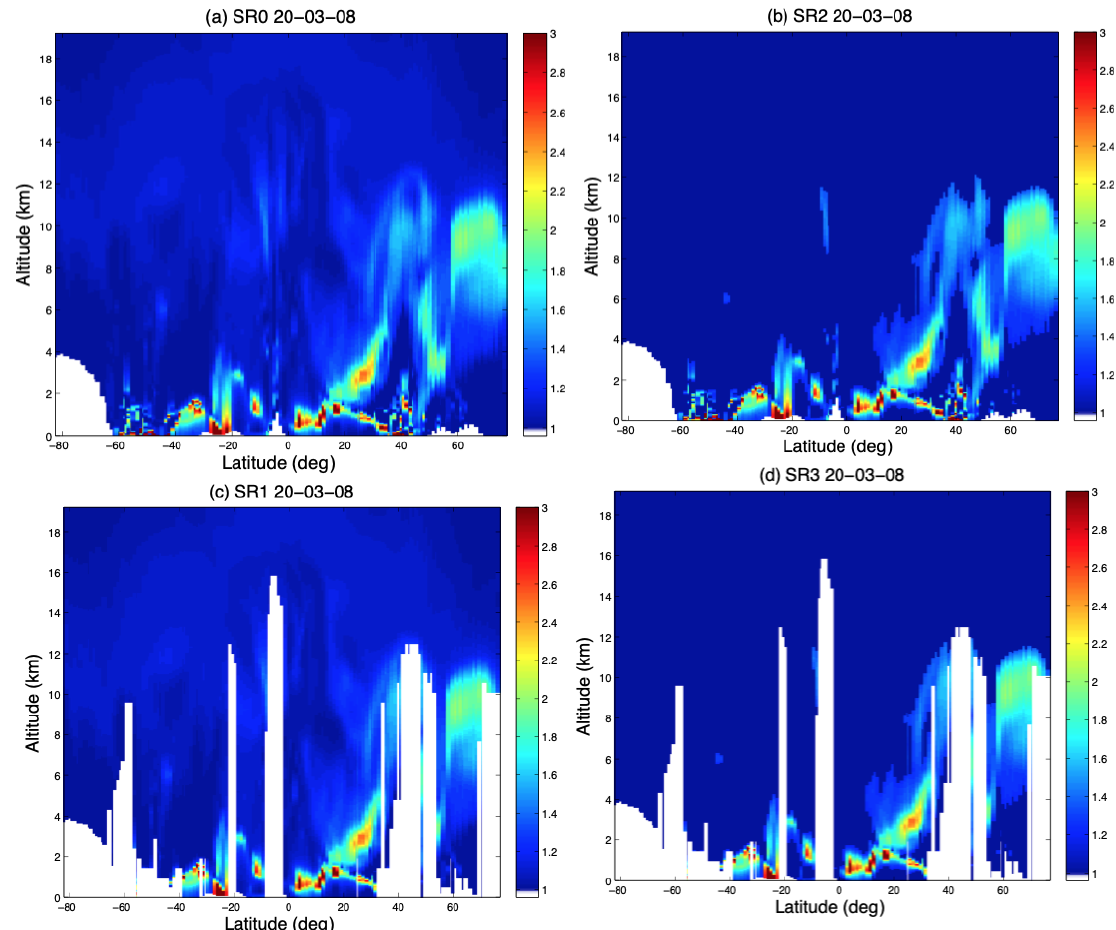
Figure 5. Backscatter ratio vertical profiles defined on 320 levels and calculated by the COSPv2 simulator along the satellite orbit on 20 March 2008: (a) initial profiles; (b) profiles with the instrument aerosol detection threshold; (c) cloud-screened profiles; (d) cloud- screened profiles with the aerosol detection threshold